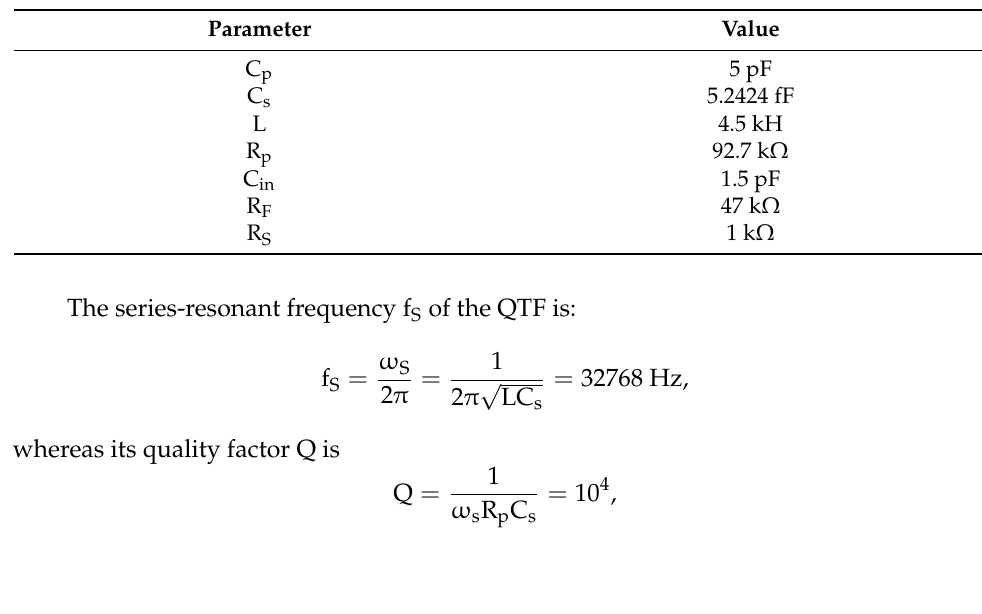
Table 1. Parameter values used to compare the results of expression in Equation (2) to SPICE